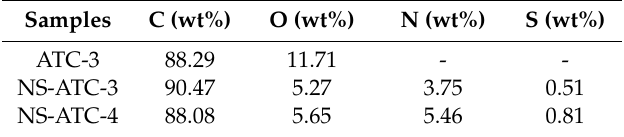
Table 3. The content of elements of the samples before and after N,